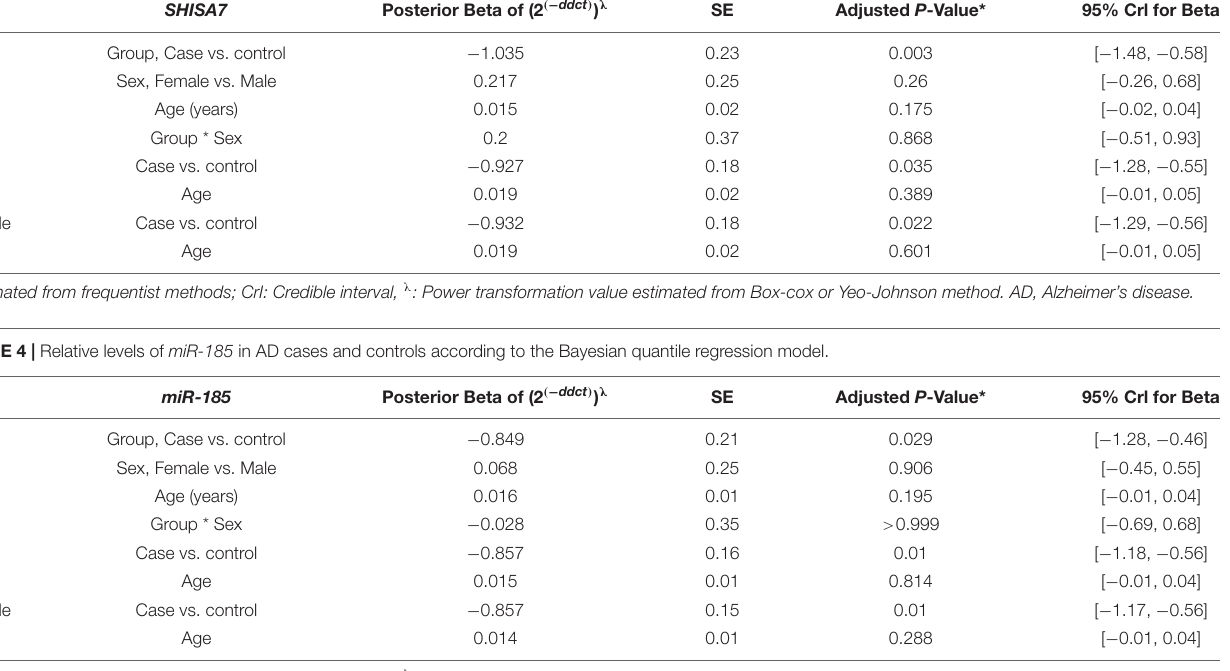
TABLE 3 | Relative levels of SHISA7 in AD cases and controls according to the Bayesian quantile regression model. SHISA7 Posterior Beta of (2 ( − ddct ) ) λ Total Group, Case vs. control